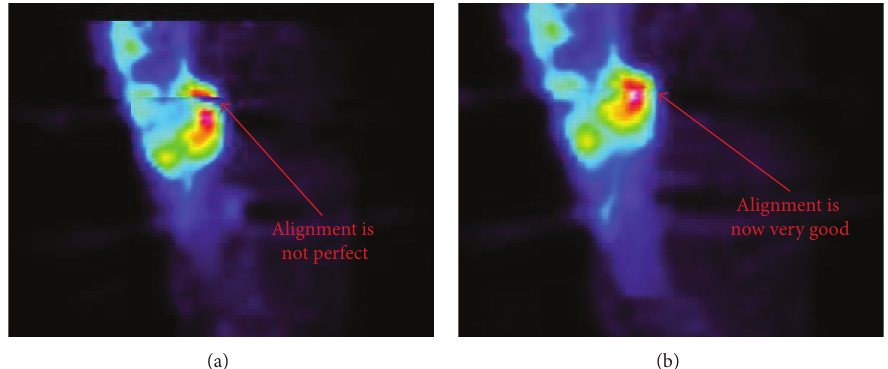
Figure 3: A sagittal section of the first PET scan for Patient 1 is superimposed on the second one. The first alignment between the exam at 40 days and at 84 days is shown in (a) and the final alignment after a slight manual adjustment in (b). This allows the same VOI to be used for the SUV calculations.